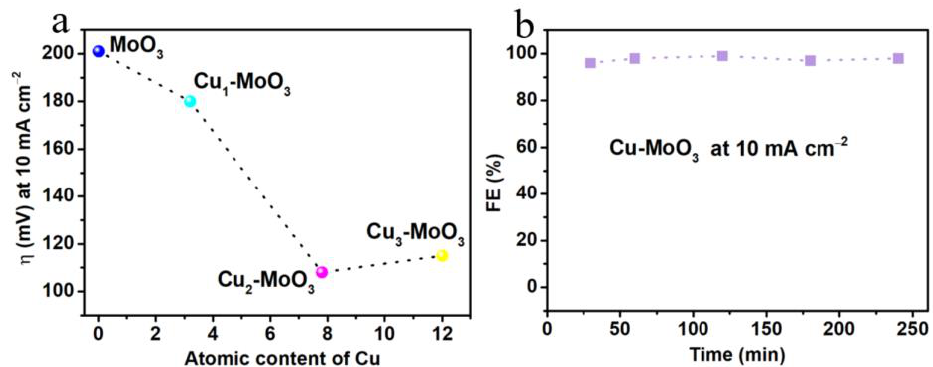
Figure 7. ( a ) The plots of HER catalytic performance of the MoO 3 nanosheet with different Cu doping. ( b ) The Faraday efficiency of Cu 2 -MoO 3 sample at 10 mA cm − 2 for HER.